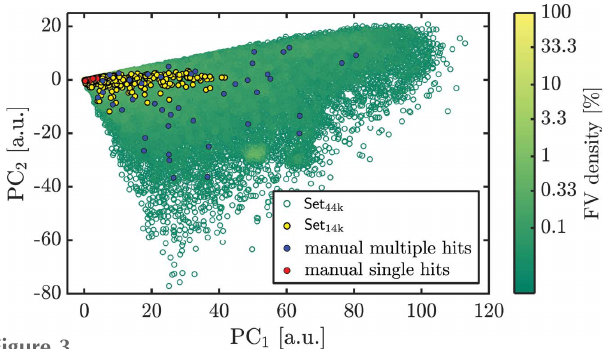
Figure 3 Projection of feature vectors onto the PCA plane. Each dot corresponds to a diffraction pattern. The green empty dots represent diffractions patterns of Set 44k and the yellow dots represent single hits of Set 14k . The manually classified patterns are marked by red (single hits) and blue dots (multiple hits).